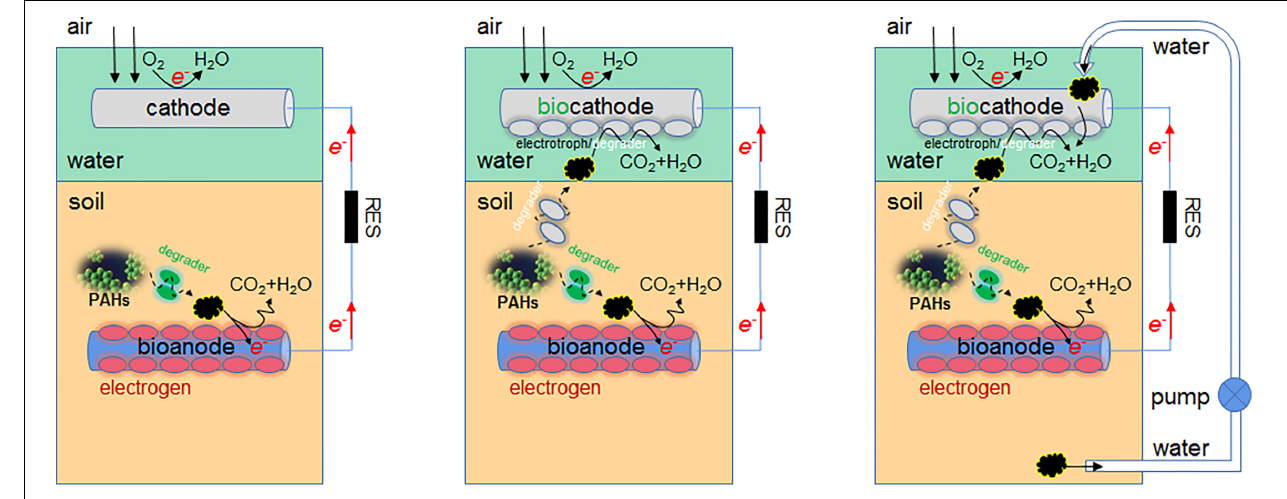
FIGURE 6 | Application prospect of biocathode in PAH